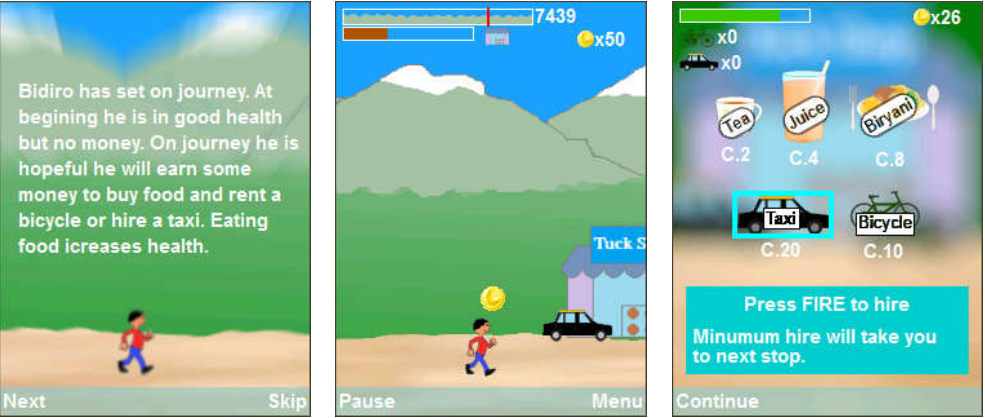
Figure 23. Different parts of OnJourney demo game.